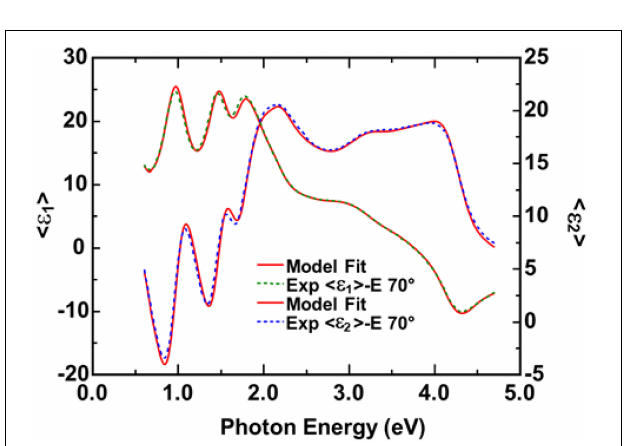
FIGURE 3 | Pseudo-dielectric function of a representative Ge 1 − x Sn x film with x = 9.6% Sn incorporation measured by UV spectroscopic ellipsometry. The solid line shows a 3-layer model fit (substrate/alloy/surface